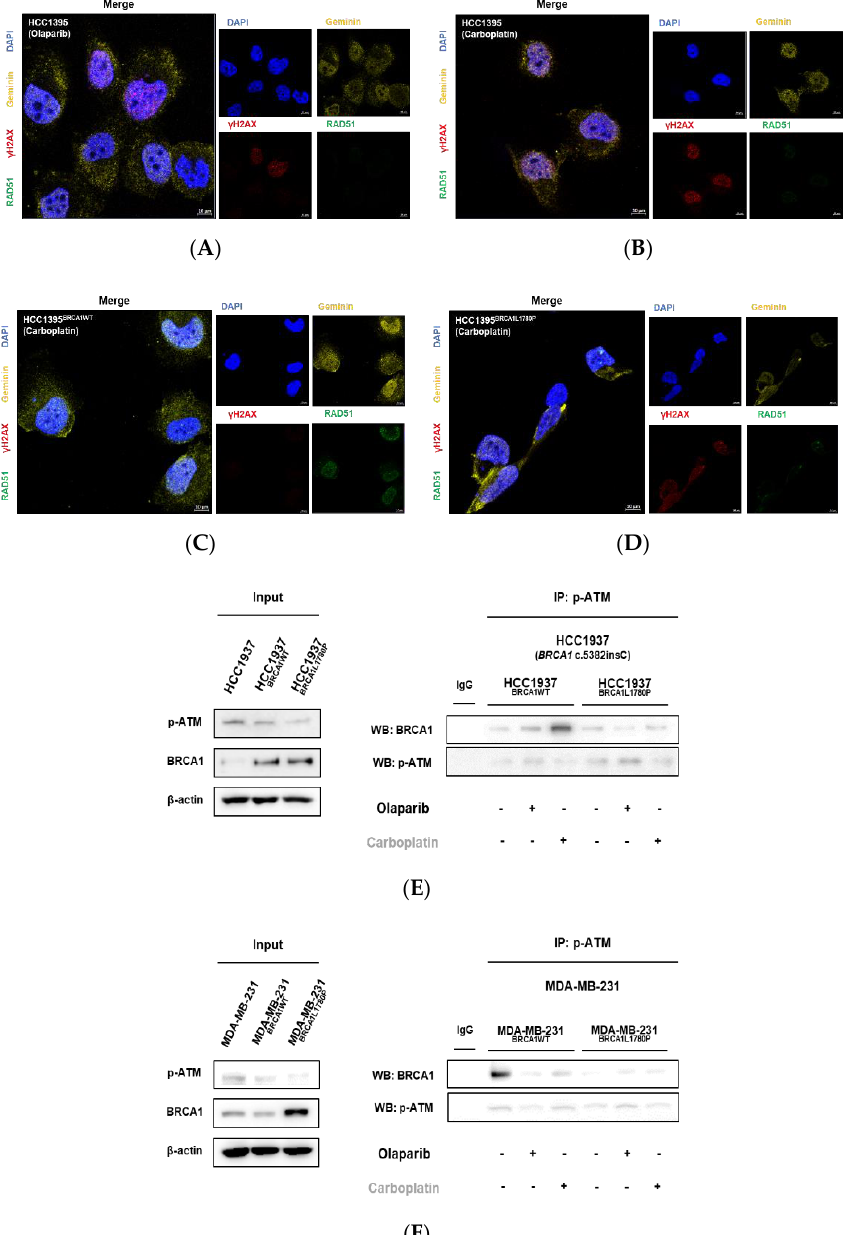
Figure 5. RAD51 recruitment to the nucleus and protein – protein interaction between p-ATM and BRCA1 in stable BRCA1-expressing cells following olaparib and carboplatin treatment. ( A , B ) RAD51 recruitment was decreased in HCC1395 cells following treatment with ( A ) olaparib and ( B ) carboplatin. ( C , D) ( C ) RAD51 expression level was restored in cells expressing exogenous BRCA1 wild-type following carboplatin treatment. ( D ) BRCA1 L1780P mutant cells showing decreased